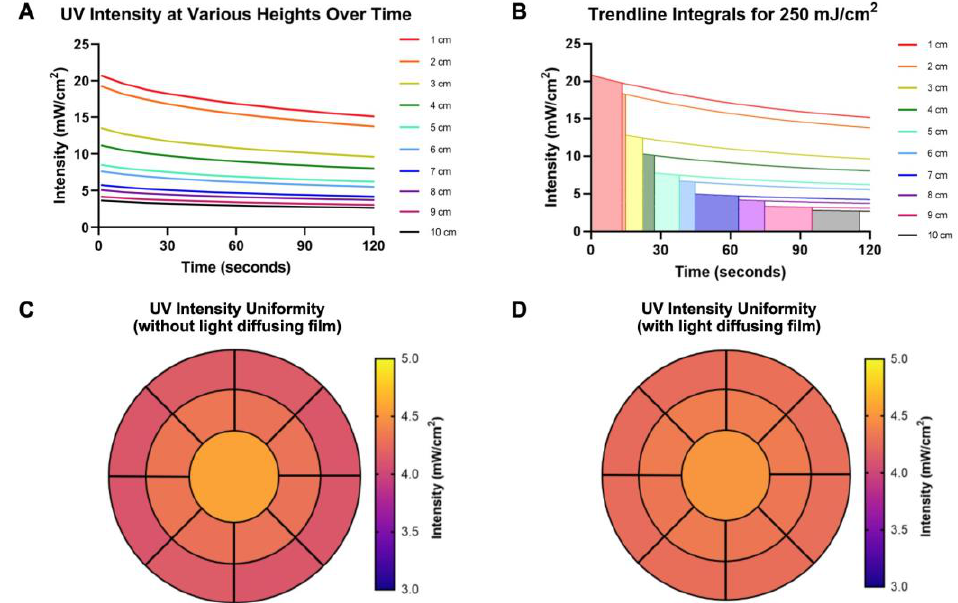
Figure 2. DUV Light System Performance Validation. ( A ) Graph of the light intensity from the UV lamp over a 2 min period. ( B ) Graph of the light intensity trendlines featuring the area under each curve corresponding to 250 mJ/ cm 2 exposure time. ( C ) UV light intensity map without the light diffusing film. ( D ) UV beam intensity map with the light diffusing film.